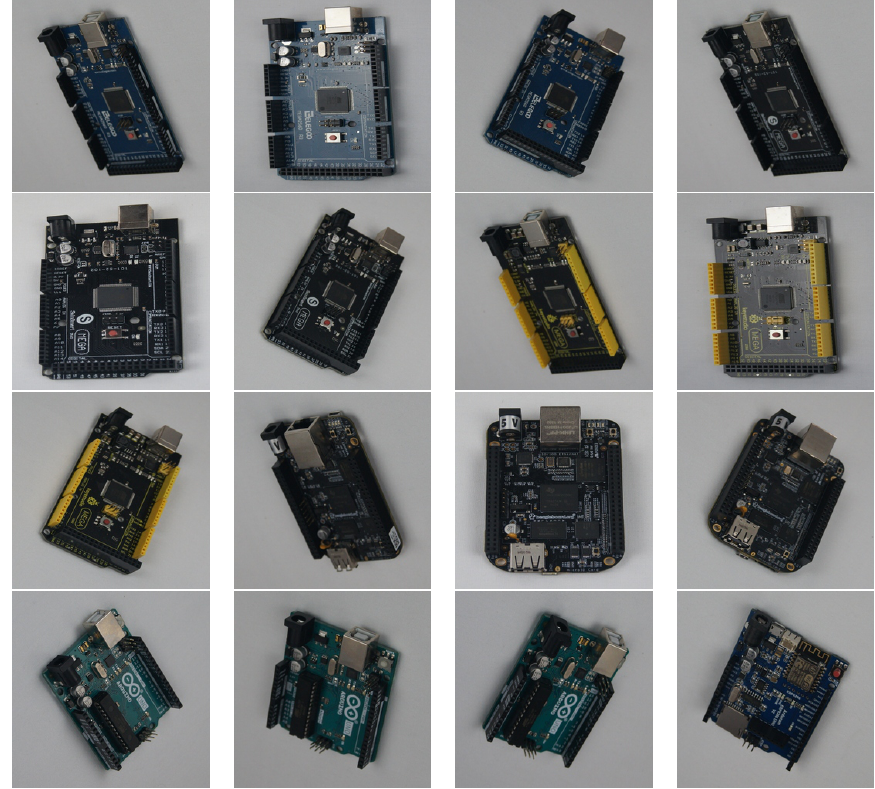
Figure 1. Display of the generated dataset and the environment during its